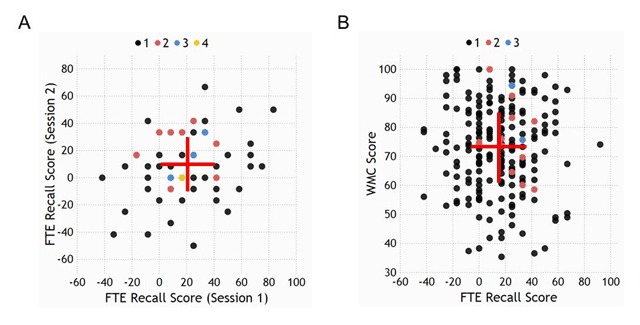
List 3 recall results. (A) Scatterplot of the significant test-retest reliability of the FTE recall score, i.e., the difference between participants’ immediate list 3 recall rates in the testing and restudy condition, in Experiment 1. The red marker indicates averaged recall rates from sessions 1 and 2. Error bars show ± 1 standard error of measurement (SEM), which is the square root of the error variance term calculated from the ICC and can be interpreted as the 68% confidence interval for an individual’s data point. Color coding of data points indicates the number of subjects having identical scores on both axes. (B) Scatterplot of the nonsignificant correlation between the FTE recall and WMC scores in Experiment 2. Error bars show ± 1 standard error or the mean for the FTE recall and WMC scores, respectively. Color coding of data points indicates the number of subjects having identical scores on both axes.